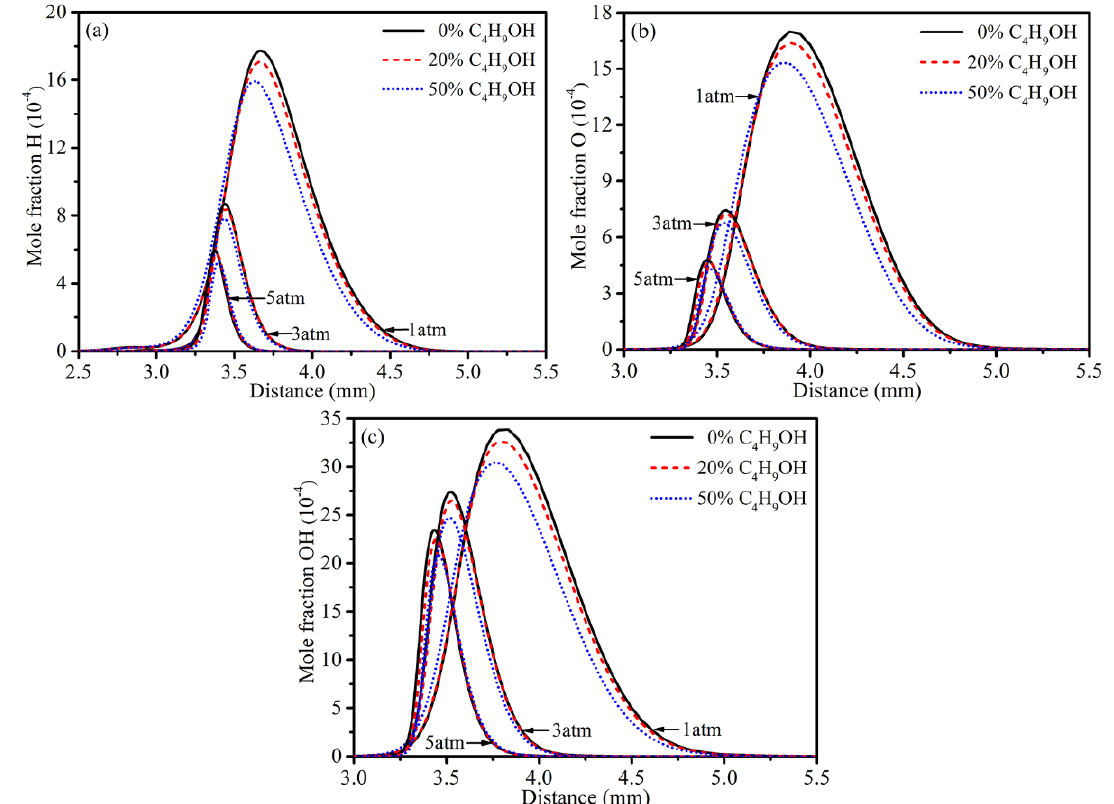
Figure 6. Mole fractions of ( a ) H radical, ( b ) O radical, and ( c ) OH radical, with different levels of n -butanol at different pressures.